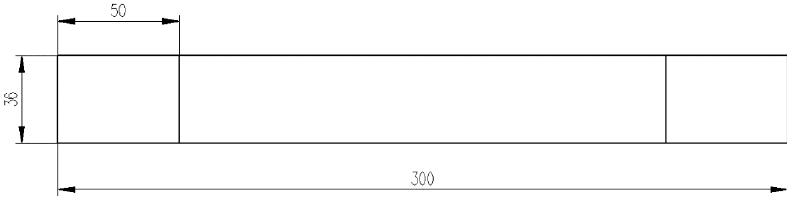
Figure 2: Drawing of no-damaged specimens for fatigue test